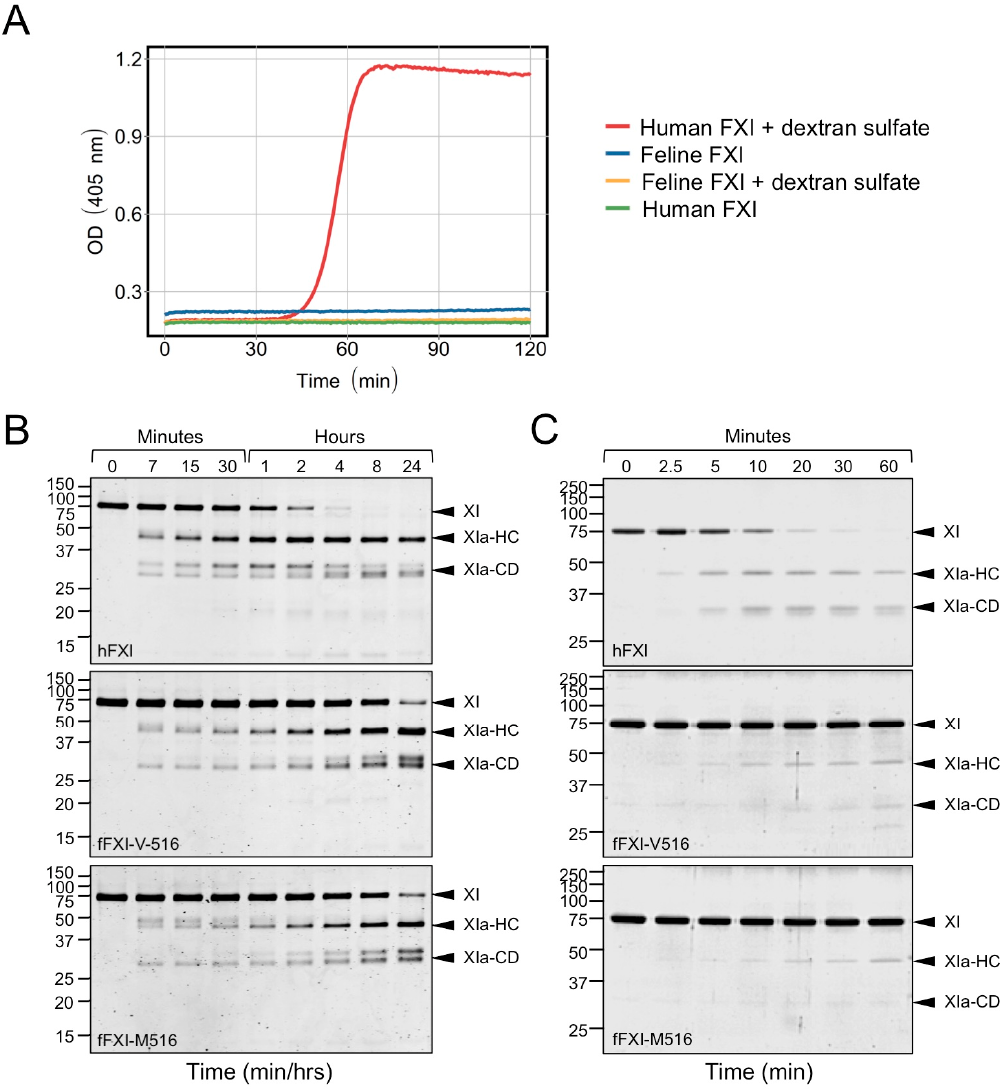
Figure 5. Factor XI activation. ( A ) Autoactivation of FXI. FXI (60 nM) was incubated with 10 µ g/mL dextran sulfate (MW 6.5 to 10 kDa) and 500 µ M S-2366. Changes in OD405 nm were